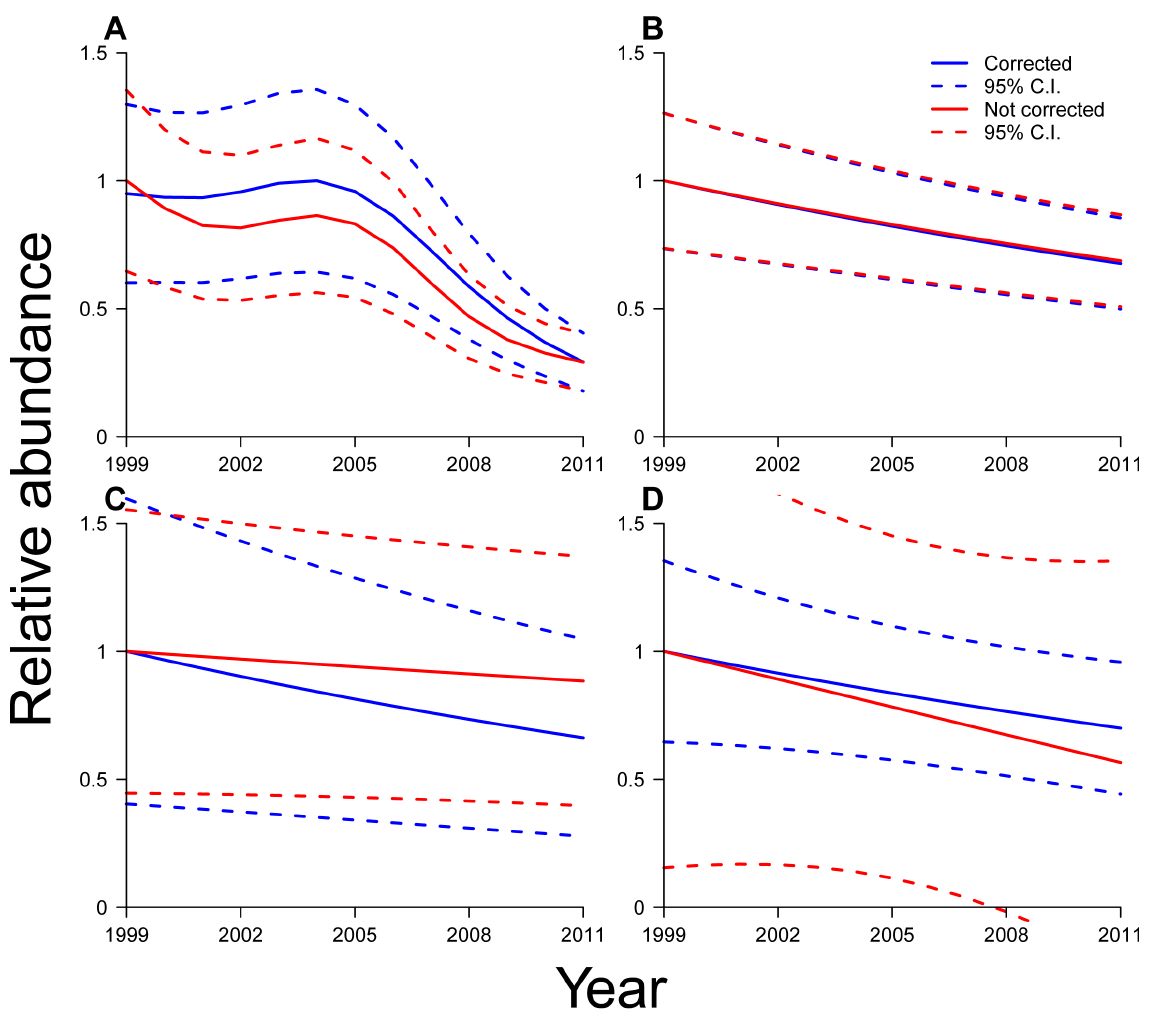
Figure 3. Long-term population trajectories. Expected relative abundance and approximate 95% confidence intervals during 1999–2011 for (A) M. lucifugus , (B) P. subflavus , (C) M. sodalis , and (D) M. septentrionalis . Relative abundance was set equal to 1.0 at the maximum expected value. Two trajectories are shown for each bat species: the trajectory with abundance estimates corrected for survey date of bat counts (in blue), and the uncorrected trajectory (red).